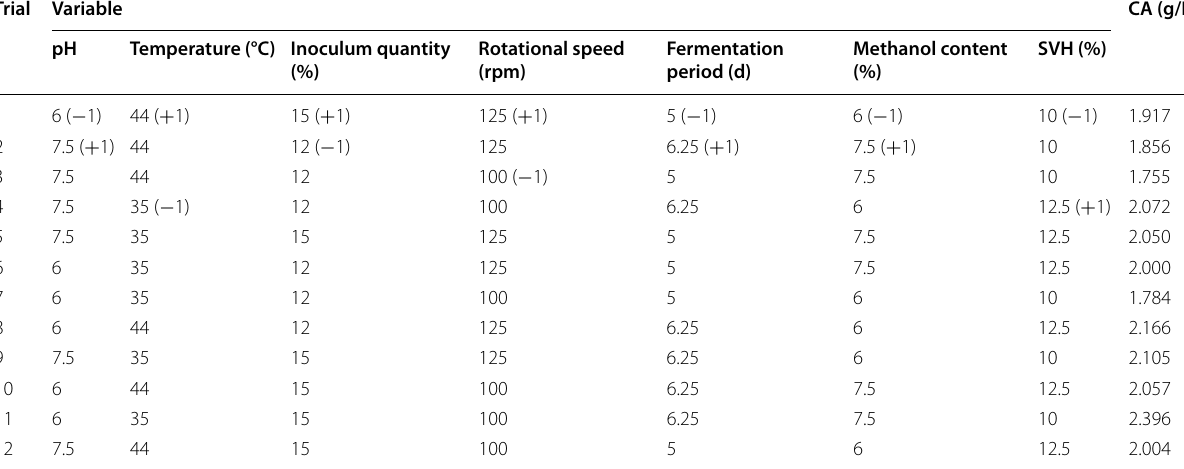
The ( 1) indicates the low −